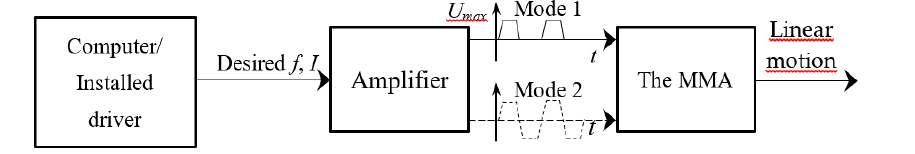
Figure 8. Open loop control .